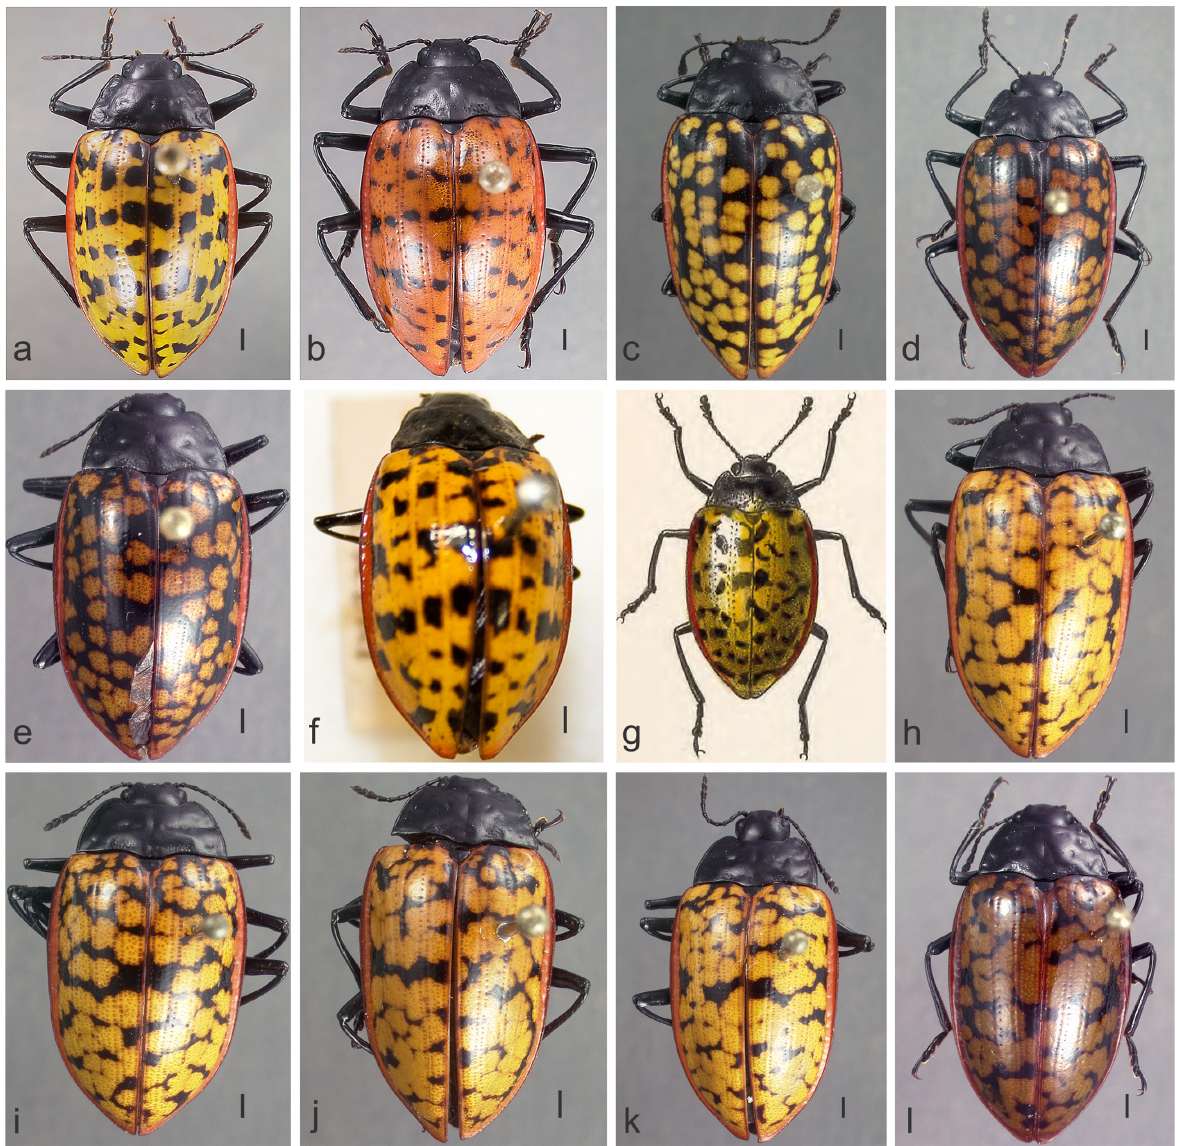
Figure 8. Erotylina leoparda (Lacordaire, 1842), morph “ nicaraguae ”, specimens from different localities. Numbers in parentheses indicate localities listed in Table I. a–e. Specimens from Costa Rica: a (1), b (3), c (4), d (5), e (6). f–l. Specimens from Nicaragua: f–g (7), h–k (8), l (9). f. Lectotype of E. nicaraguae from Santo Domingo (Chontales, Nicaragua) . g. Specimen illustrated in Biologia Centrali-Americana (Gorham 1888). Scale bars = 1 anterior edge concave, anterior angles sharp. Scutellar shield BW 0.89 mm, subpentagonal, nearly rounded laterally, glabrous, shiny. Elytra with no anterior marginal bead and sides evenly arched to apex (conspicuously arched at 3/4 of elytra); EL/EW = 1.32 EL/PL = 4.59; with 5–6 striae evident by rows of distinct punctures,